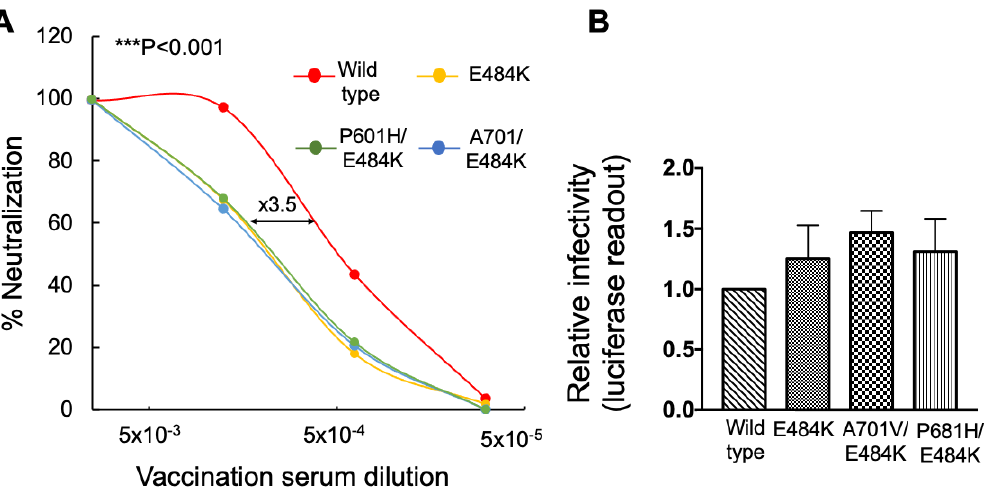
Figure 3. E484K RBD mutation reduces neutralization sensitivity of pseudoviruses carrying Furin Cleavage Site spike mutations against post-vaccination sera. ( A ) E484K spike mutation reduces neutralization sensitivity of pseudoviruses that carry a Furin Cleavage Site against post-vaccination sera. Neutralization assays were performed by transducing HEK293T-ACE2 cells with pseudovirus displaying a wild-type SARS-CoV-2 spike or its FCS-P681H/E484K or V710A/E484K combined mutants, in the presence of increasing dilutions of sera drawn from post vaccinated individuals. In addition, 48 h post transduction, cells were harvested and their luciferase readings were monitored. Neutralizing potency was calculated at increased serial dilutions, relative to transduced cells with no sera added. Neutralization, NT 50 , is defined as the inverse dilution that achieved 50% neutralization. Results are the average of two independent biological experiments. Triplicates were performed for each tested serum dilution. Black bars represent geometric mean of NT 50 values, indicated at the top. Statistical significance was determined using one tailed t -test *** < 0.001. ( B ) E484K RBD mutation has a moderate impact on infectivity levels of SARS-CoV-2 Furin Cleavage Site spike mutation-Pseudoviruses bearing wild-type SARS-CoV-2 spike or the indicated P681H/E484K or A701V/E484K combined mutants were used to transduce HEK293T-ACE2 cells. Equal viral loads were normalized based on p24 protein levels. Furthermore, 48 h post transduction, cells were harvested and their luciferase readouts were monitored. Bar graphs show mean values ± SD error bars of three independent